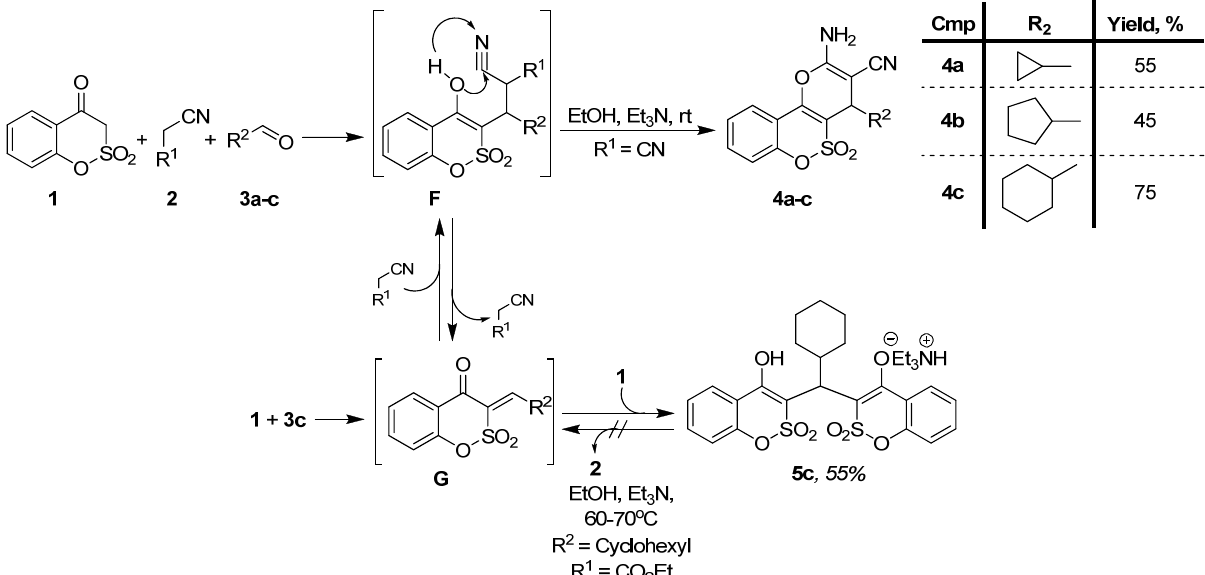
Fig. 3. Synthesis of 2-amino-4-cycloakyl-4,6-dihydropyrano[3,2- c ][2,1]benzoxathiin-3-carbonitrile